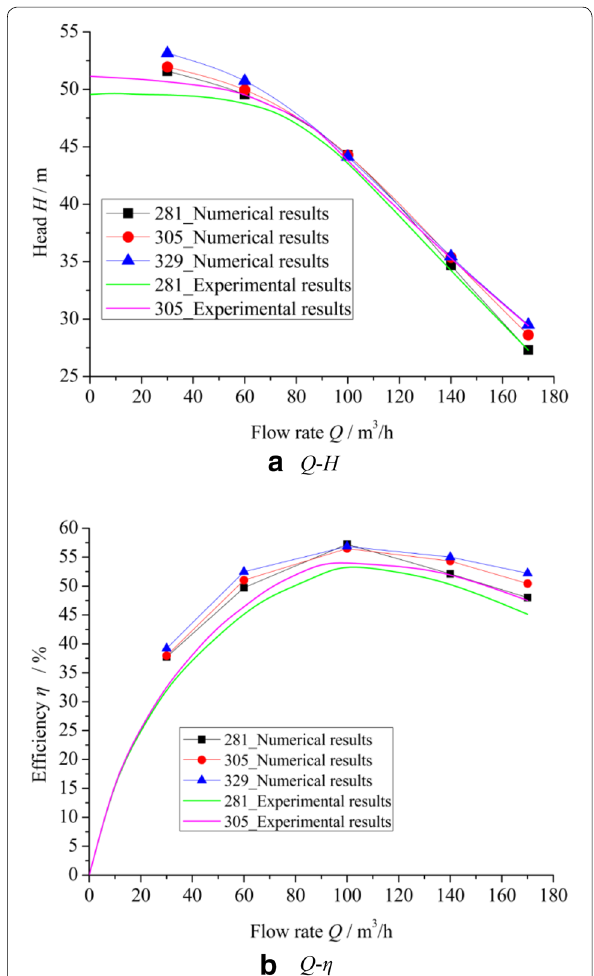
Figure 4 Comparison of numerical and experimental